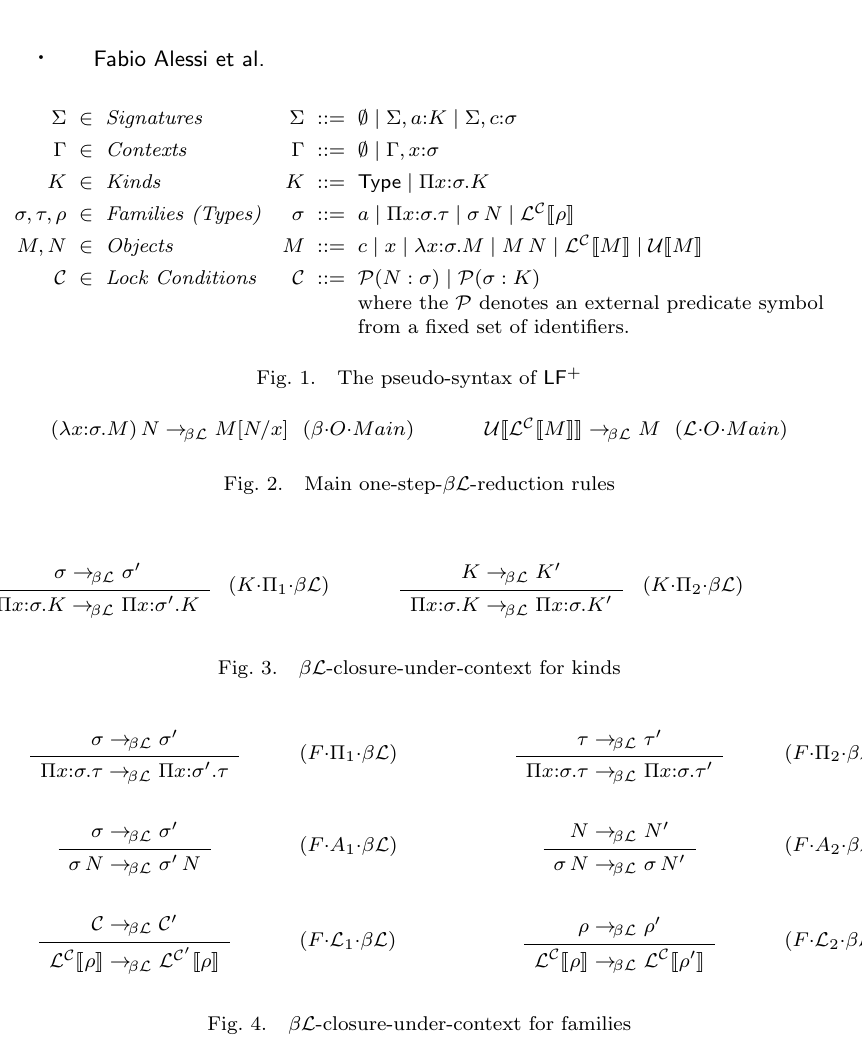
Fig. 4. β L -closure-under-context for